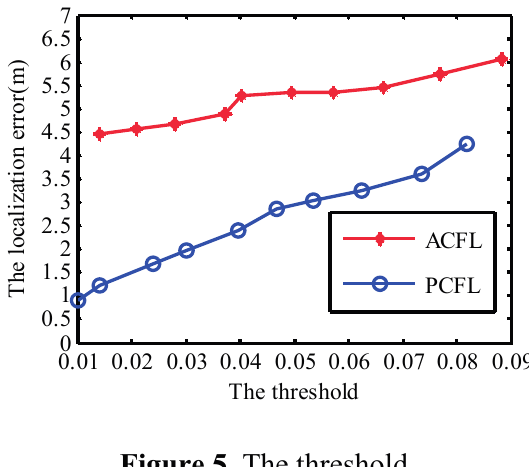
Figure 5. The threshold.